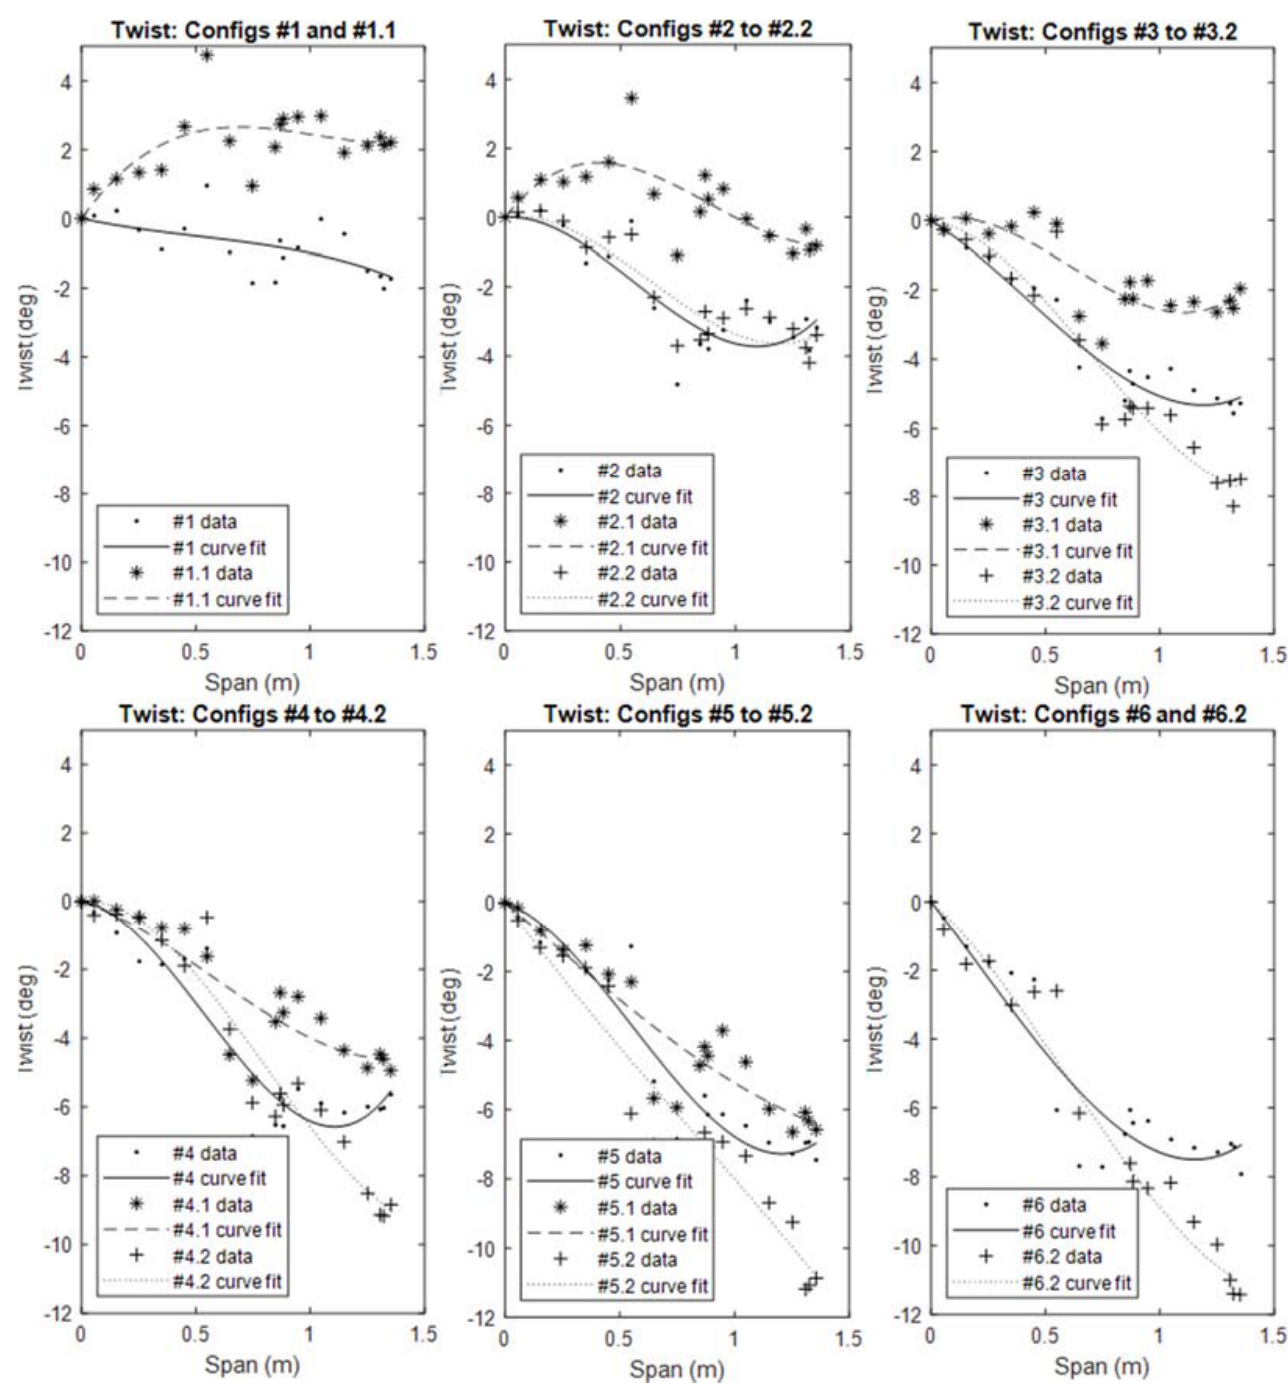
Figure 9. Spanwise twist for the selected configurations.